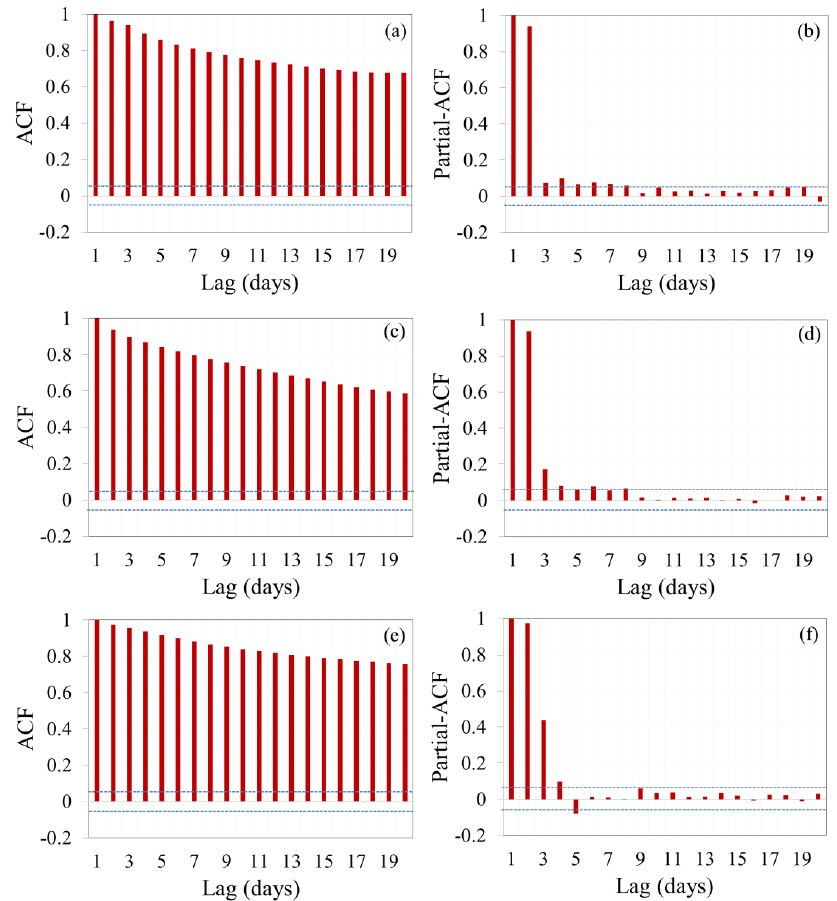
Figure 4. The auto-correlation function (ACF) and partial auto-correlation function (PACF) graphs of the daily streamflow for Siira ( a , b ), Bilghan ( c , d ), and Gachsar ( e , f ) stations used to develop predictive models.